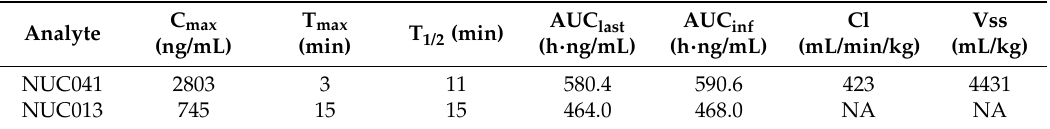
Table 2. Pharmacokinetic parameters calculated from concentrations of NUC041 and NUC013 in whole blood following IV administration of NUC041 (15 mg/kg) to mice in LNE vehicle. Where: C max : Maximum observed concentration in blood. T max : (1) NUC013: Time of maximum observed concentration in blood; (2) NUC041: First sampling time. T 1/2 : Half-life of the terminal elimination